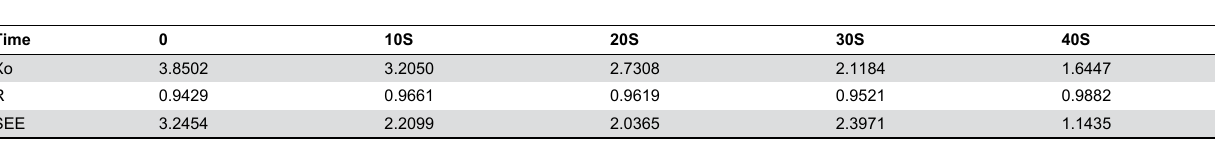
Table 3. Values in Gaussian distribution of Figure.